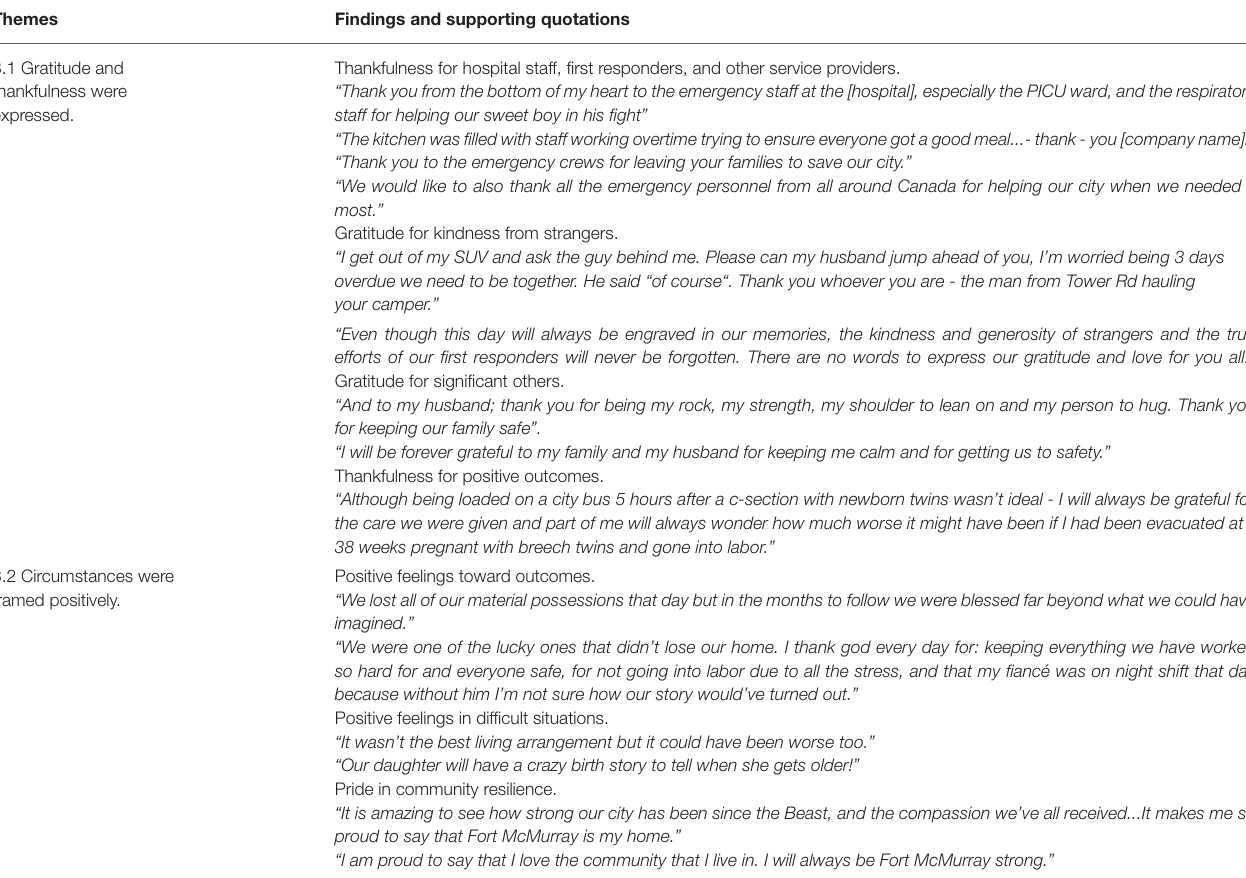
TABLE 3 | Theme 3: Performance of resilience enhancing activities.